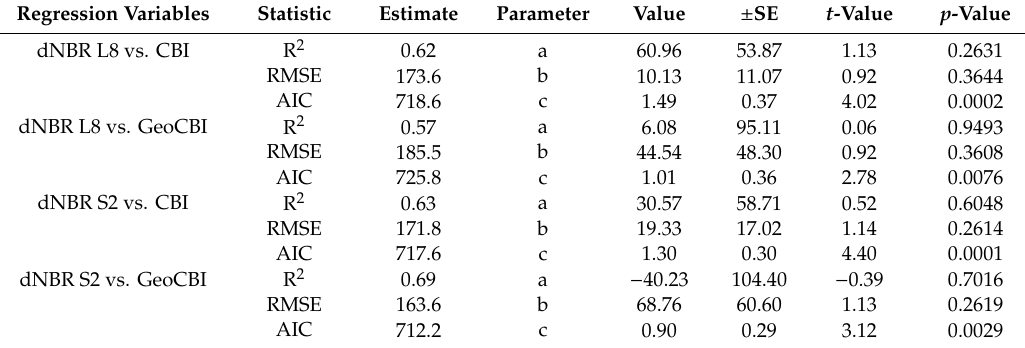
Table 3. Goodness of fit statistics and parameters of regression models estimated by combining field-based (CBI and GeoCBI) and satellite-based (dNBR L8 and dNBR S2) burn severity metrics. Each regression model was estimated from the training dataset (n = 54 plots). R 2 , RMSE and AIC correspond respectively to the coe ffi cient of determination, root mean square error, and Akaike’s information criterion. For each regression parameter a, b, and c estimated values, standard error ( ± SE), student t -value and p -value are reported. Regression Variables Statistic Estimate Parameter Value ± SE t -Value p -Value dNBR L8 vs. CBI